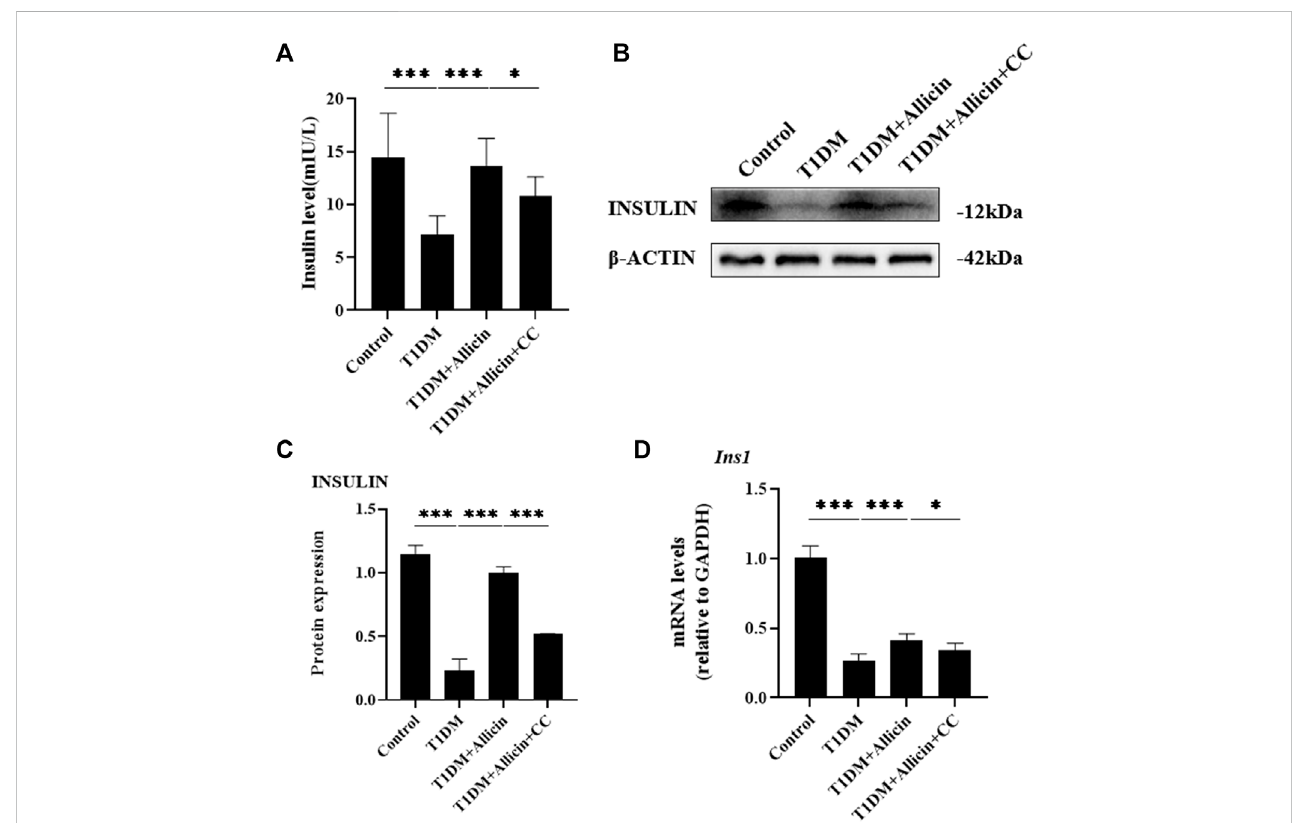
FIGURE 5 Allicin improved the insulin secretion function of STZ-induced pancreatic β cell Min6 in vitro . (A) ELISA analysis of the insulin levels in the cell culture supernatantfrom each group. (B) Western blotgel images ofINSULIN and β -ACTIN in each group. (C) The bar graphs represent the quanti fi cation of INSULIN protein levels. (D) The mRNA levels of Ins1 in each group by RT-qPCR. N = 3, Mean ± SD. *p < .05, **p < .01, ***p < .001 indicate signi fi cant